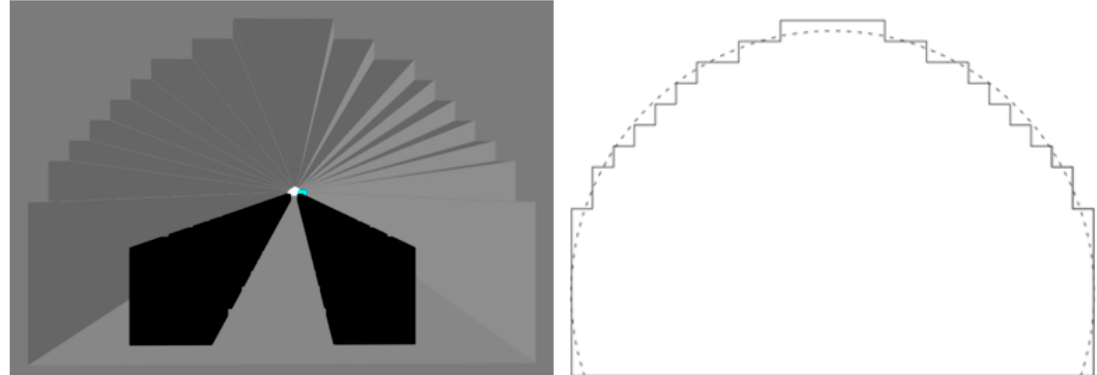
6 of 17 Table 2. Grid sensitivity analysis: temperature values at driving lane center 5.5 m from the road pavement.